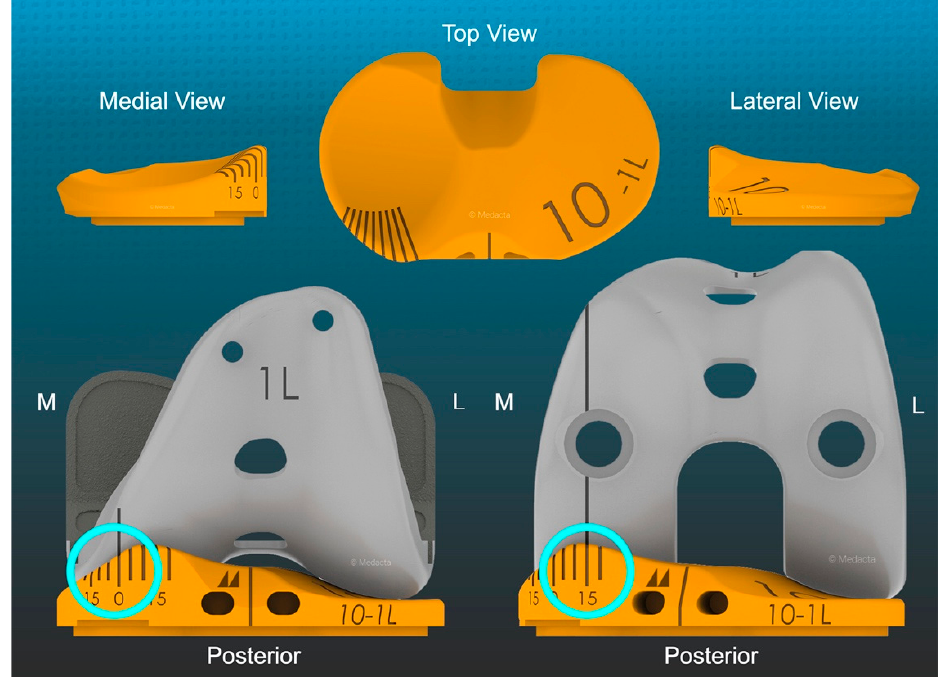
Figure 1. Schematics showing poses of the trial insert goniometer (top row) and the measurement of 0° external orientation or screw-home movement in extension and 15° internal tibial orientation at 90° flexion (cyan circles) relative to a laser etched sagittal line (black) on the femoral component (bottom row) (GMK Sphere, Medacta).